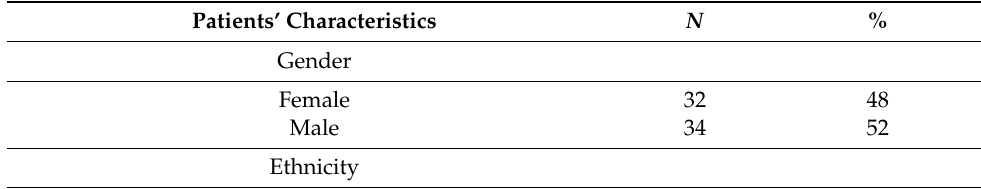
Table 1. Summary of patients’